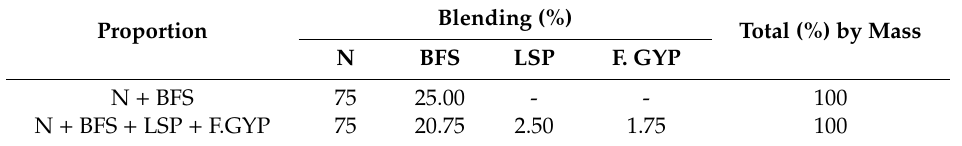
Table 2. Percent by mass of binder per cubic metre of concrete.